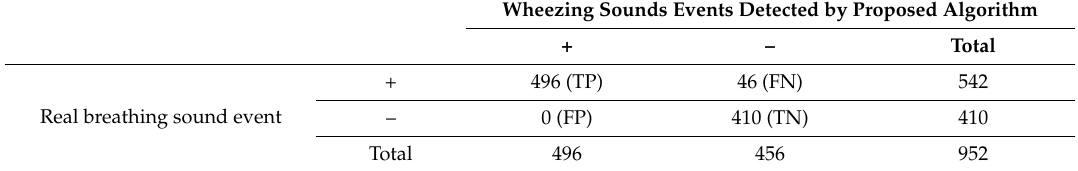
Table 2. Performance of proposed method on wheeze